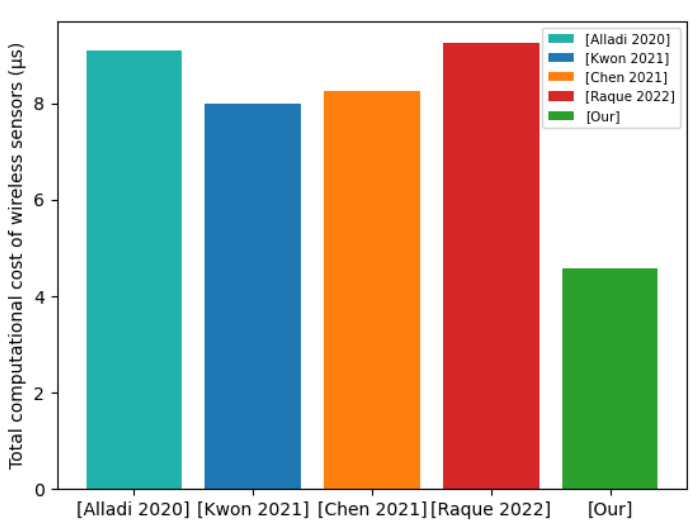
Figure 5. Total computational cost of wireless sensors.